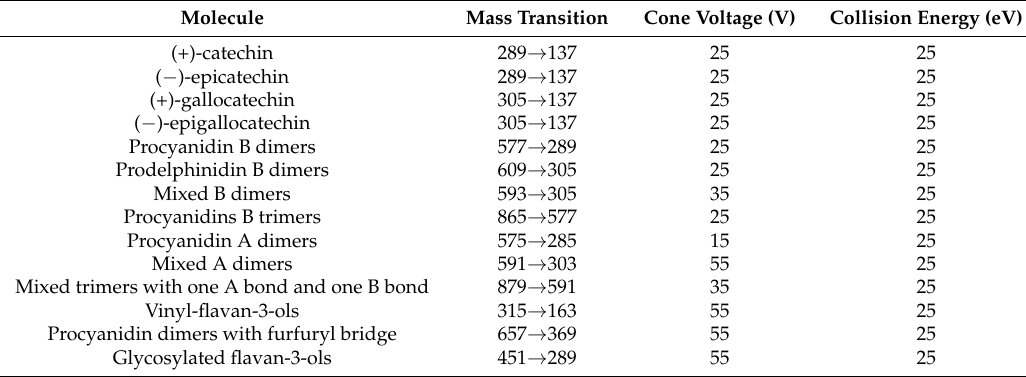
Table 6. Determination of individual tannins: parameters of multiple reaction